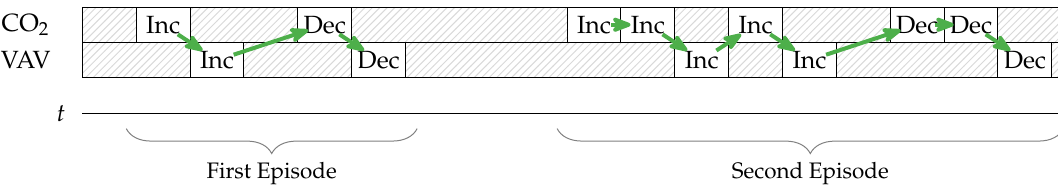
Figure 4. Episodes involving multiple time-series. Episodes are sequences of events and are represented with green arrows. The first episode corresponds to a typical threshold-based VAV actuation: when CO 2 level increases, the VAV unit opens, which in turns causes CO 2 level to decrease after some time, and thus the VAV unit to close. The second episode corresponds a more complex dynamics involving the two